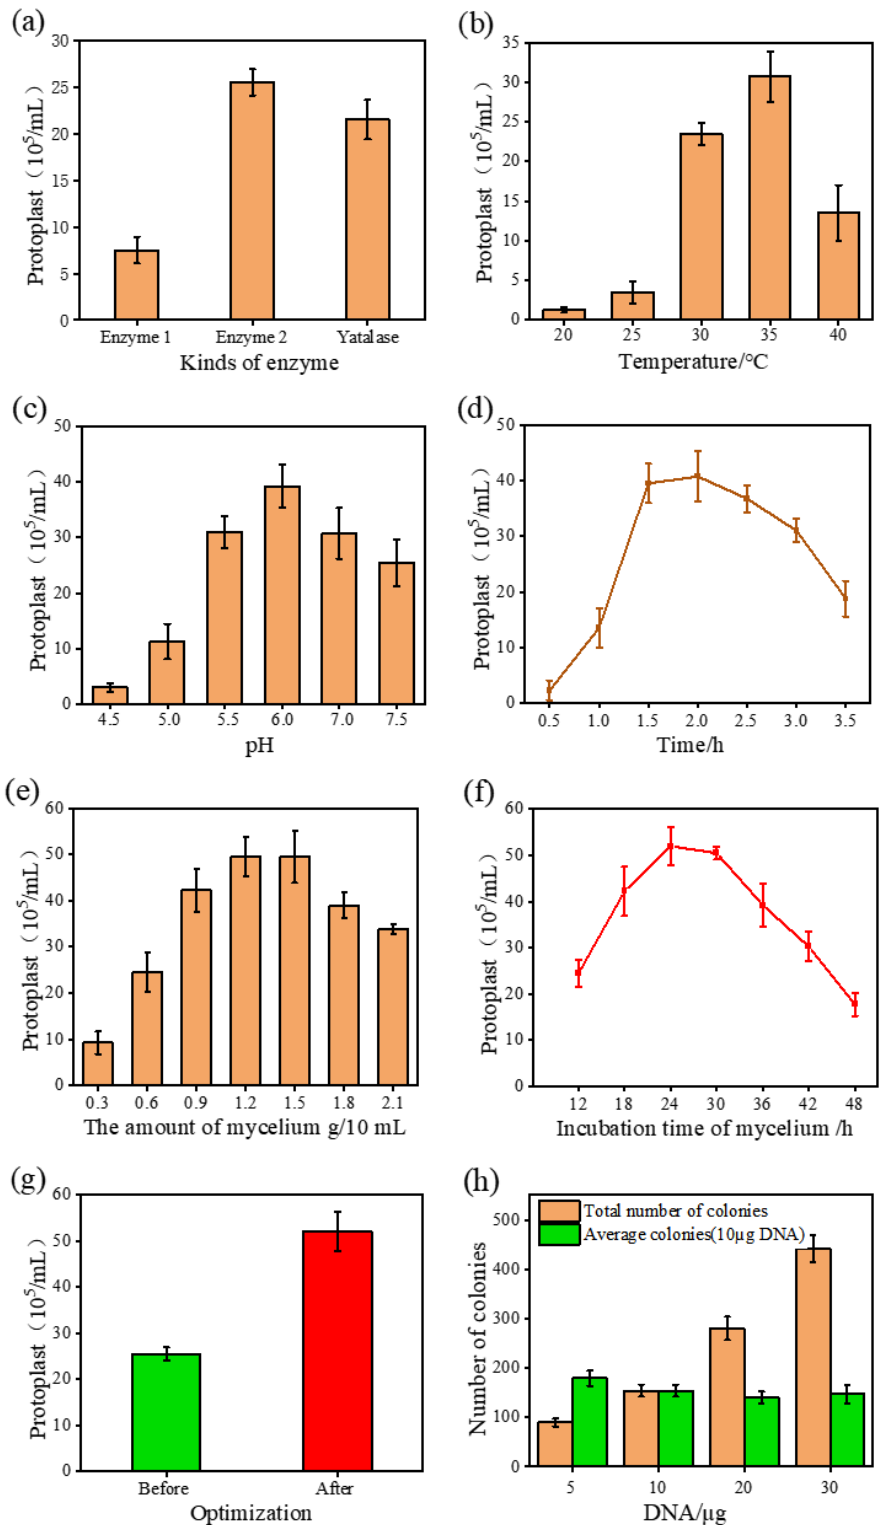
Figure 1. Optimization of conditions for protoplast preparation. ( a ) Comparison of different complex enzymes. ( b ) Effect of temperature on protoplast preparation. ( c ) Effect of pH on protoplast prepa- ration. ( d ) Effect of hydrolysis time on protoplast preparation. ( e ) Effect of mycelium amount on protoplast preparation. ( f ) Effect of mycelial culture time on protoplast preparation. ( g ) The effect of optimization of protoplast preparation. ( h ) Transformation efficiency of different DNA contents after